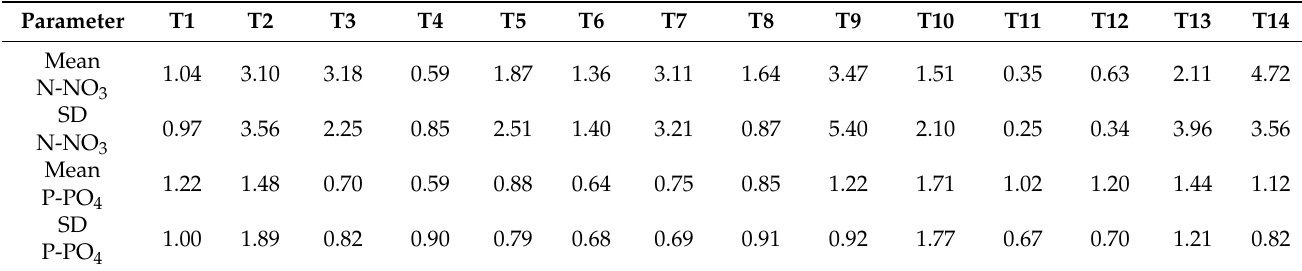
Figure 4. Spatial and seasonal variability of N-NO 3 ( a and b , respectively) and P-PO 4 ( c and d , respectively) across the sampling sites from April 2019 to March 2020. Table 3. Mean and standard deviation (SD) values for N-NO 3 and P-PO 4 concentrations in mg/L in the investigated catchments, calculated for the sampling period from April 2019 to March